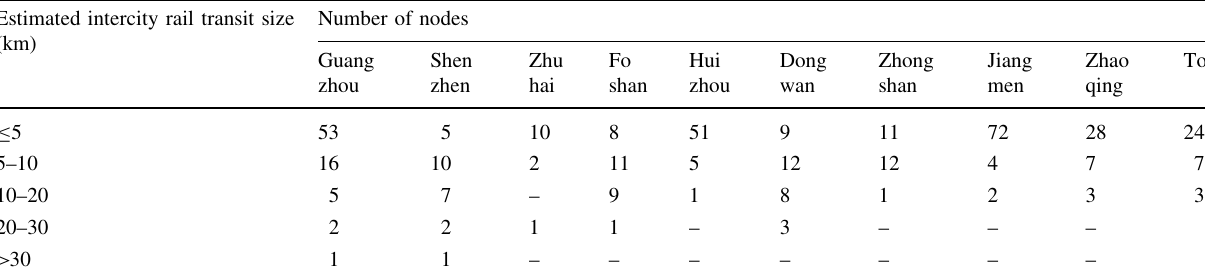
Table 4 Estimated intercity rail transit size for each city Estimated intercity rail transit size (km)